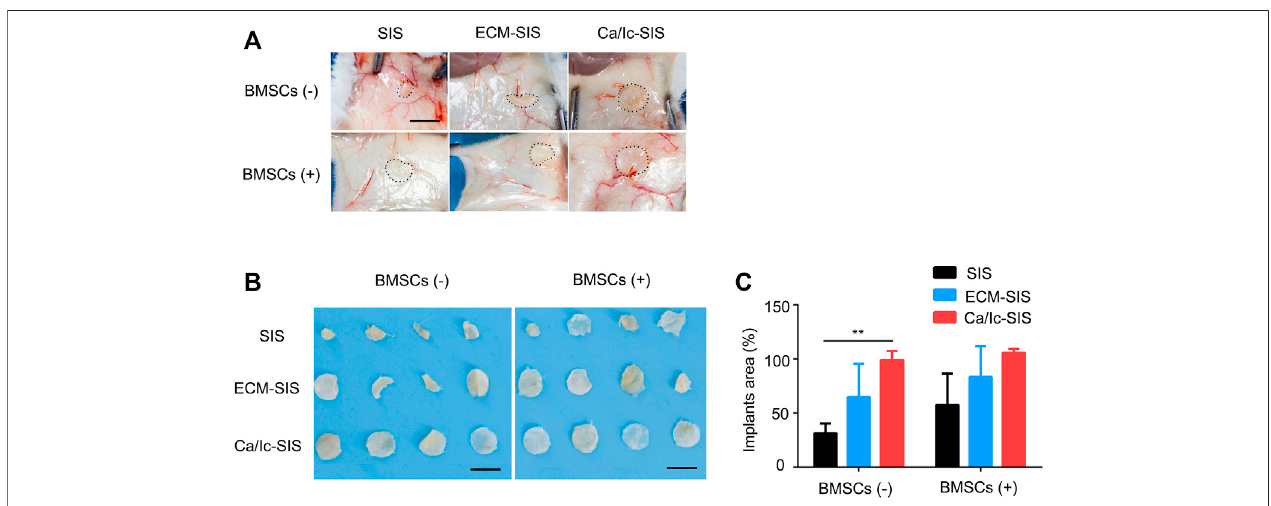
FIGURE 2 | Degradation pro fi les of the SIS, ECM-SIS, and Ca/Ic-SIS scaffolds (seeded with or without BMSCs) after 8 weeks. Gross views in vivo (A) and in vitro (B) . (C) Quantitativeanalysisofthedegradationofthesixscaffolds(SIS,ECM-SIS,Ca/Ic-SIS,SIS+BMSCs,ECM-SIS+BMSCs,andCa/Ic-SIS+BMSCs).TherawSIS scaffoldsweresigni fi cantlydegradedintoasmallsize,andnodetectabledegradationwasobservedinthecaseoftheCa/Ic-SIS+BMSCsscaffolds.Mean+S.D.( n (cid:1) 4). **, p < 0.01. Scale bar: 5 mm.